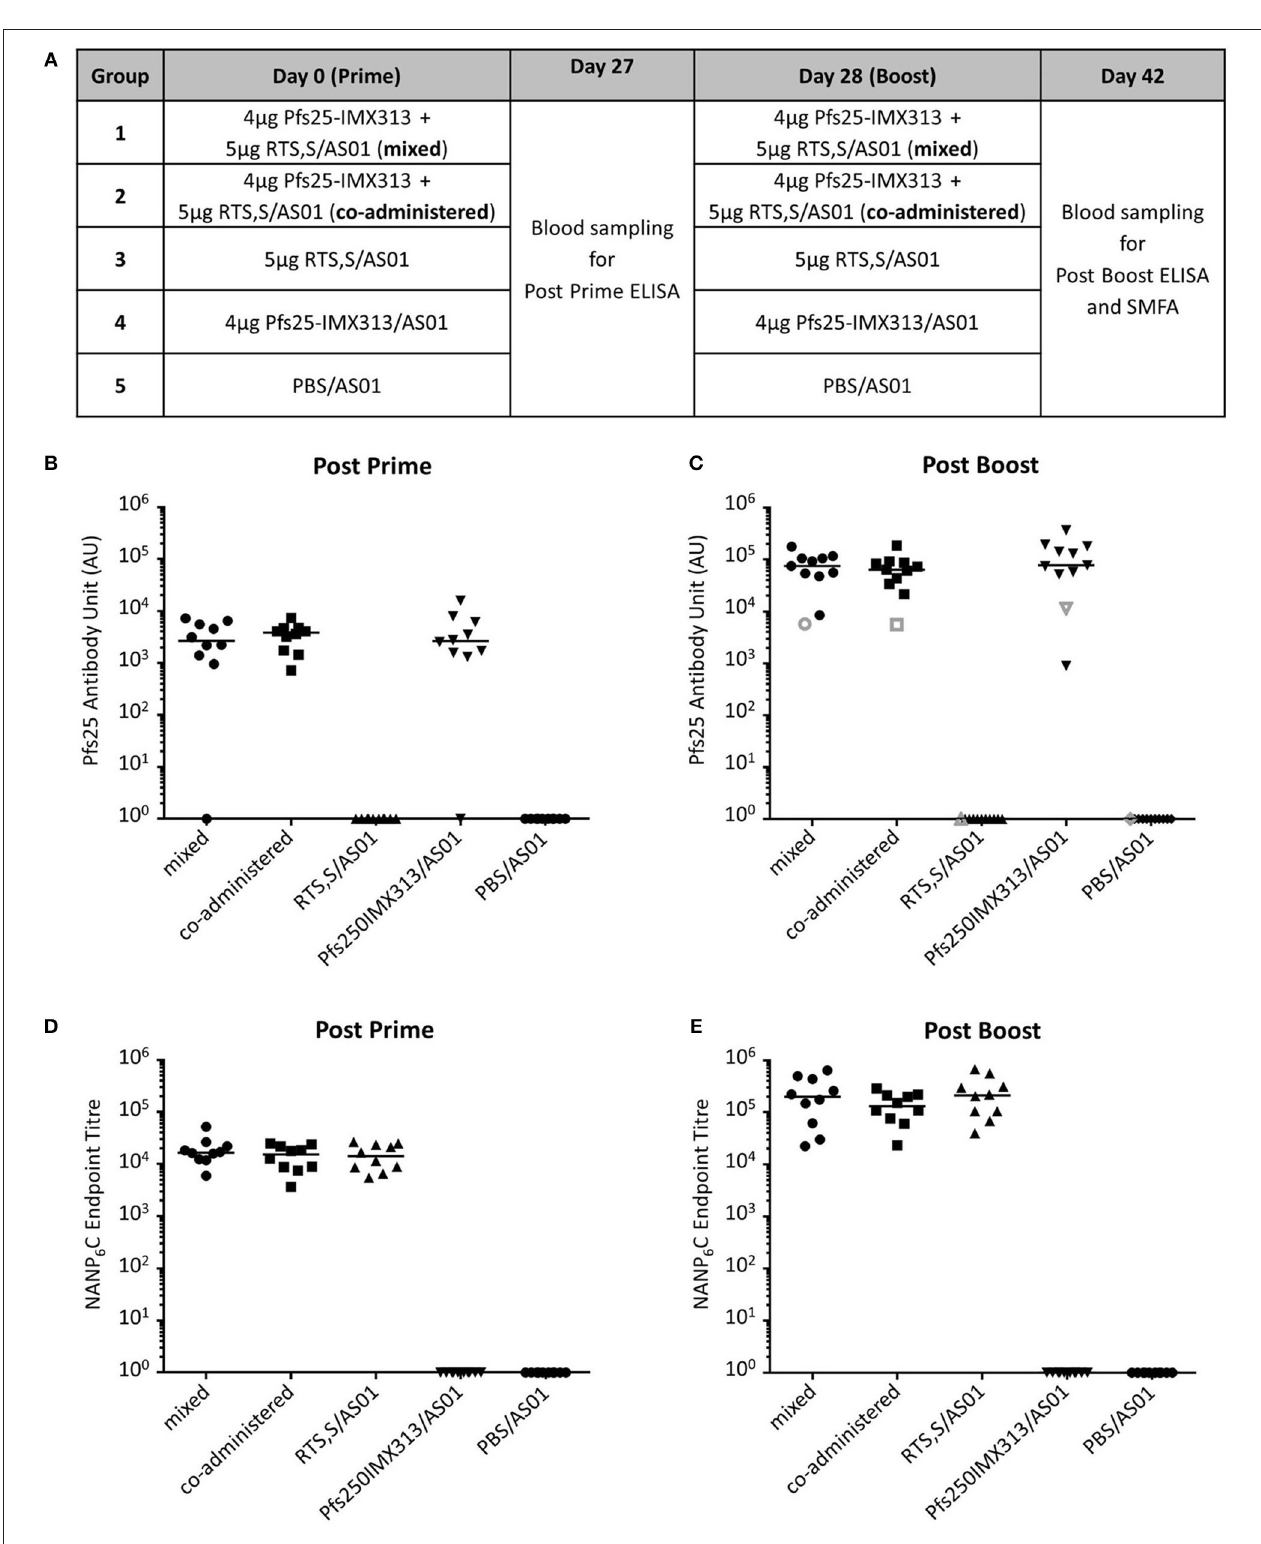
FIGURE 3 | Immunogenicity of Pfs25-IMX313 and RTS,S alone or when combined. (A) CD1 mice ( n = 10) were vaccinated twice with (1) a mixture of 4 µ g Pfs25-IMX313 and 5 µ g RTS,S/AS01, (2) 4 µ g Pfs25-IMX313/AS01 and 5 µ g RTS,S/AS01, administered separately in individual hind legs, (3) 5 µ g RTS,S/AS01 and (4) 4 µ g Pfs25-IMX313/AS01. A control group (5) was immunized with PBS + AS01. (B,C) Anti-Pfs25 IgG titres were measured by ELISA at 4 weeks post prime